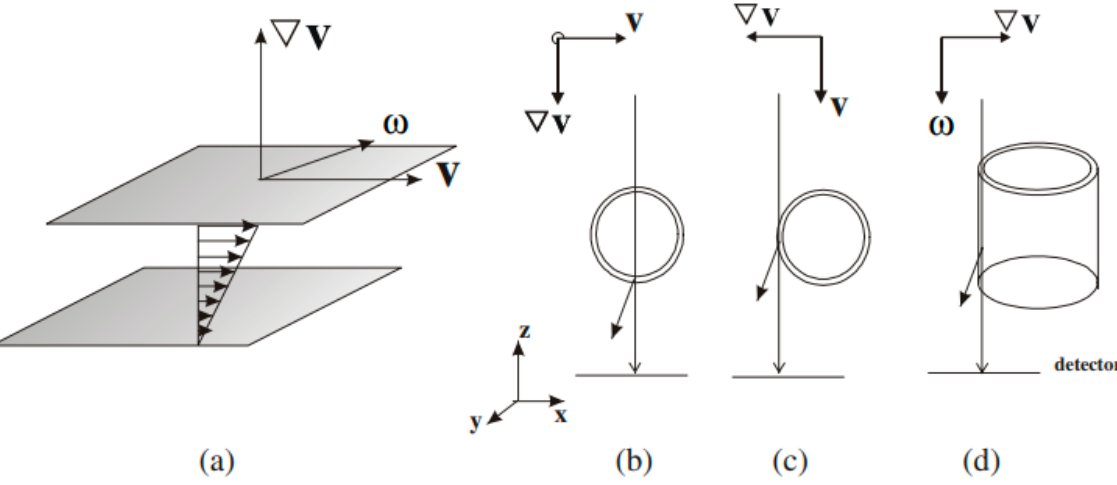
Figure 5. The different configurations in which a Couette type shear cell can be used. The different flow fields are indicated with v indicating the flow direction, ∇ v the flow gradients, and ω the vorticity direction ( a ). In neutron scattering experiments, the 1–3 ( b ) and 2–3 ( c ) directions can be probed with a cell having a vertical rotation axis. On the other hand, the 1–2 ( d ) direction requires a cell with a horizontal rotation axis. Figure provided by J. Vermant [43].